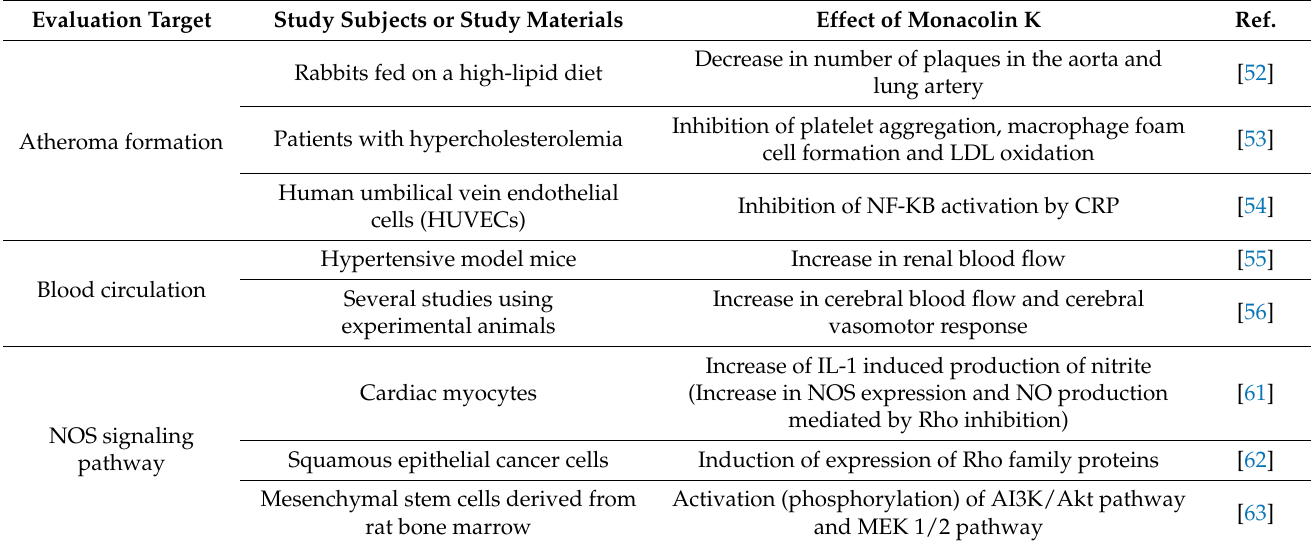
Table 4. Actions of monacolin K (lovastatin) on circulatory system and related fields. Evaluation